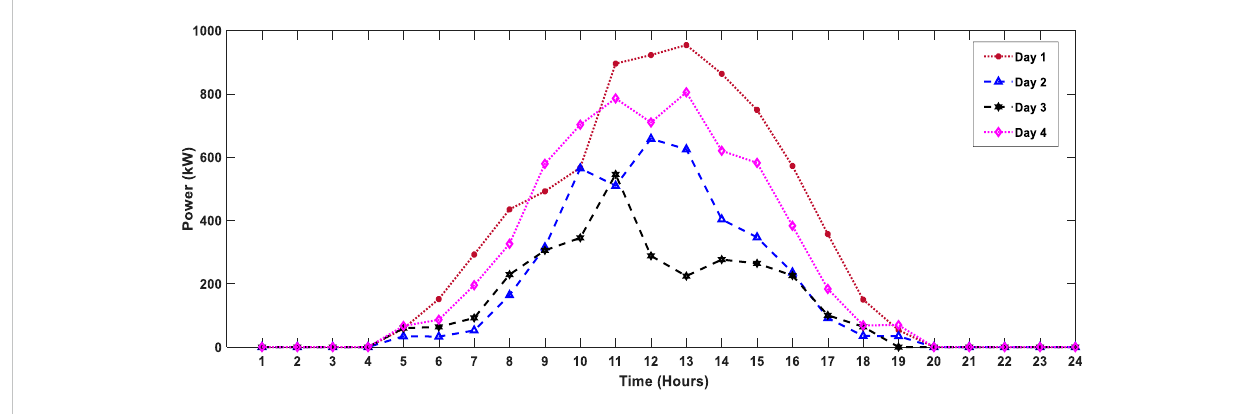
FIGURE 5 Typical 4-day forecasted PV power for the industrial microgrid (Khezri et al., 2021).